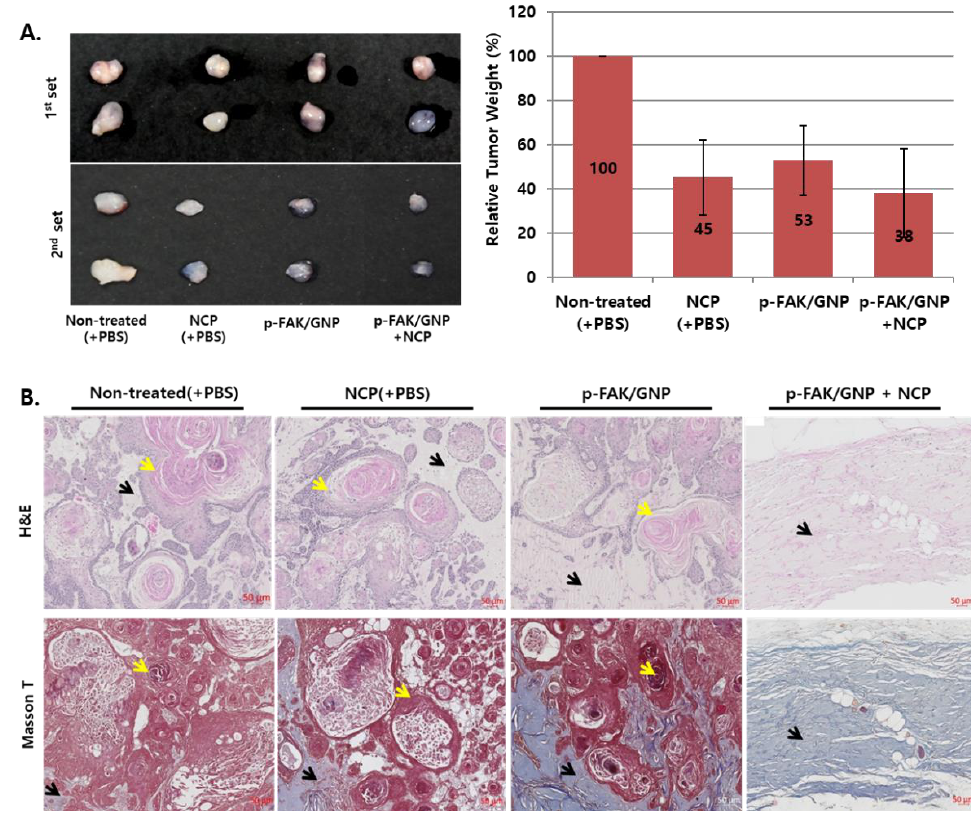
Figure 6. The tissues isolated from the p-FAK/GNP+NCP group were mainly composed of collagen, not SCC25 cells. ( A ) Photographs (left) showing the size and appearance of tissues isolated from each group, and a graph (right) showing the relative weight of isolated tissues. Data shown are the average of each group ’s mice ( n = 4). ( B ) The results of H&E and Masson ’s T staining using the isolated tissues from each group. Data shown are representative of each group. Yellow arrow: keratinization; Black arrow: collagen. Scale bar: 50 μm.